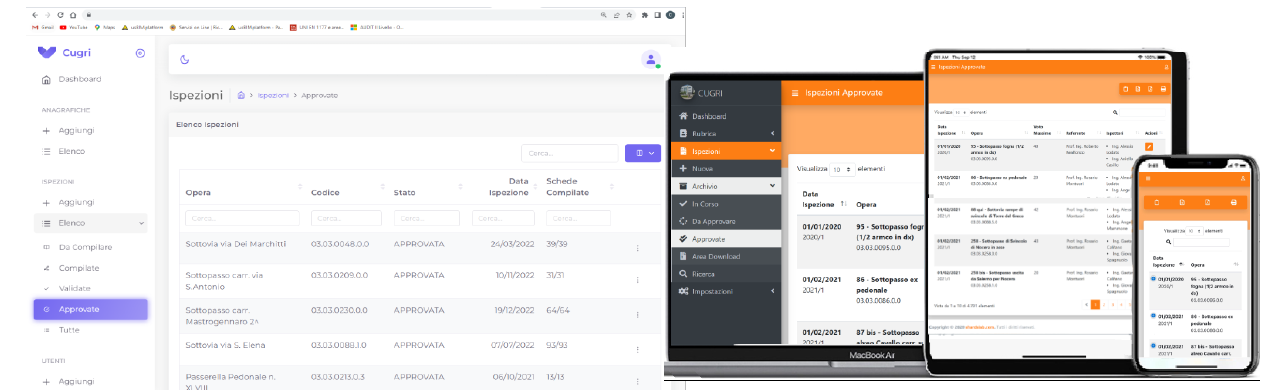
Figure 6. CUGRI Information System (IS), cloud ( left ), and APP ( right ) format. Each bridge is georeferenced in a GIS platform and modeled in BIM, where each main component is represented in order to uniquely distinguish it. The BIM models of the bridges were developed with Autodesk REVIT software through a systematized procedure configured as an algorithm designed to simplify the entire process, called Scan-to-BIM